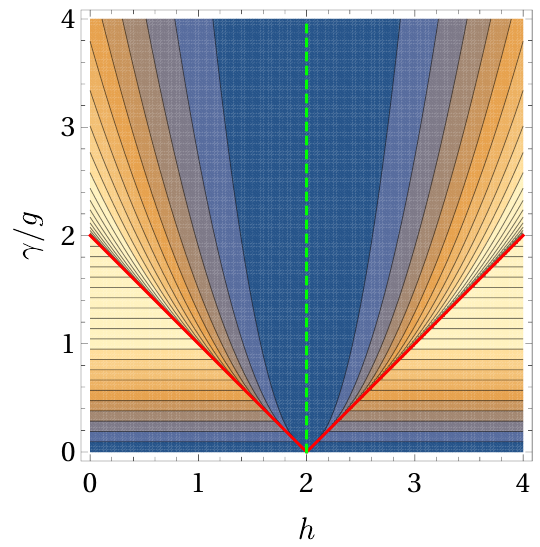
Figure 3: Spectral gap of the topological model for α = 1 as a function of h and γ/ g . Darker tones correspond to smaller values of the gap, and lighter tones to larger values. The dashed green line corresponds to the topological to trivial phase transition discussed in Section 3.3, while the red lines denote the limit of the “Zeno” regime, where the gap decreases under increasing γ